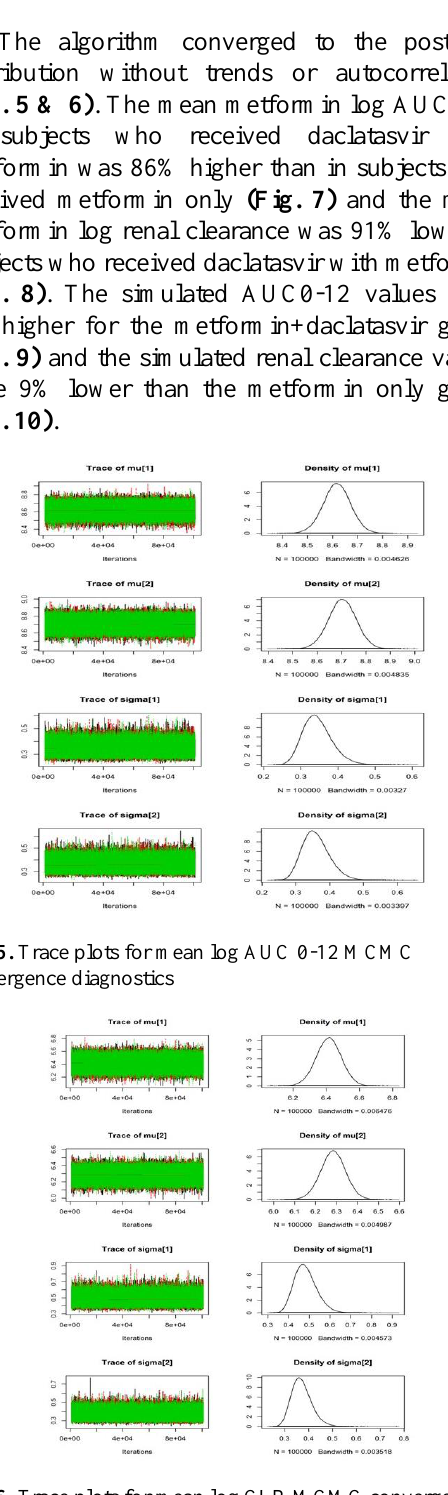
Fig. 6. Trace plots for mean log CLR MCMC convergence diagnostics